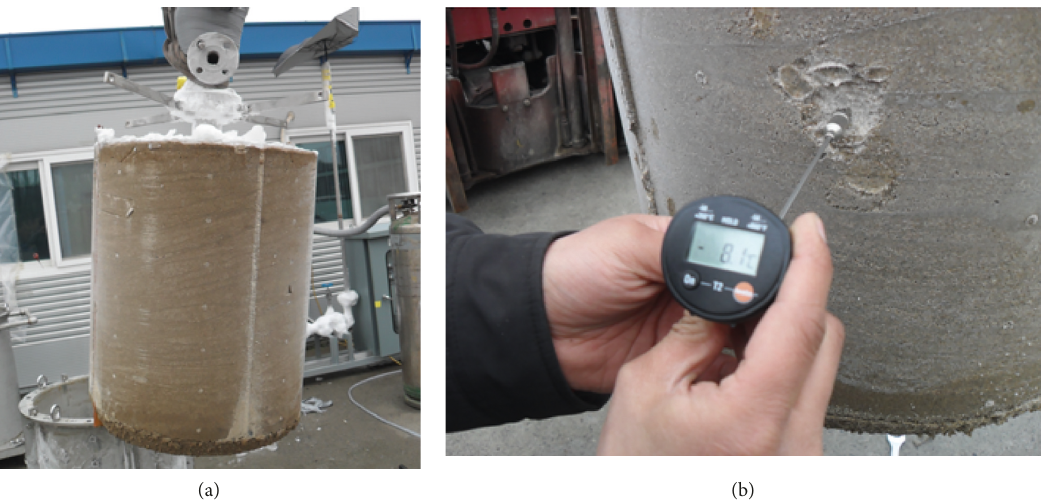
Figure 7: Extraction of frozen sand sample and measurement of surface temperature.